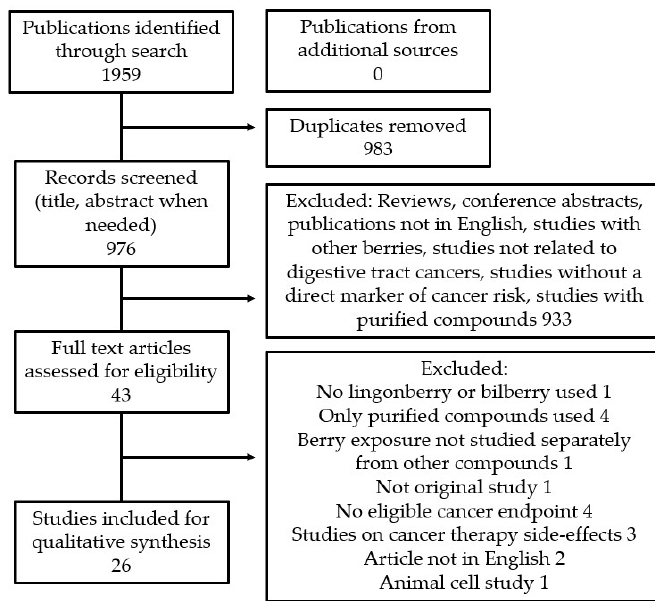
Figure 1. Flow chart of the systematic search and selection process.